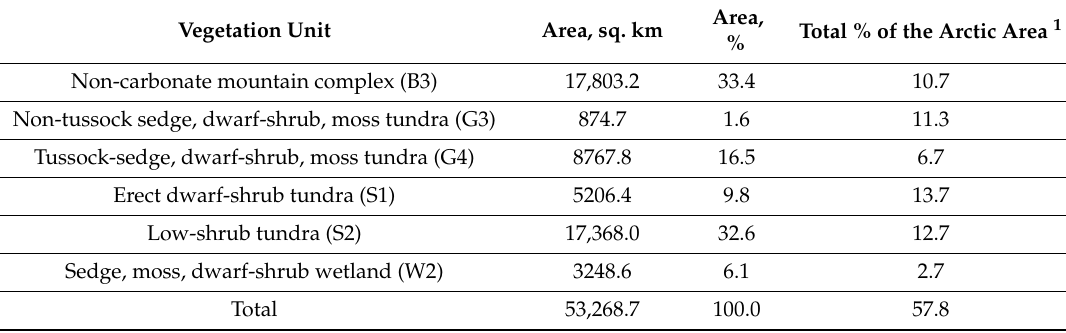
Figure 2. Aerial photos of the Circumpolar Active Layer Monitoring (CALM) sites made from UAV (Unmanned aerial vehicle) in 2018. Table 1. Vegetation units of Eastern Chukotka coastal plains and their representation for the Arctic region [33].